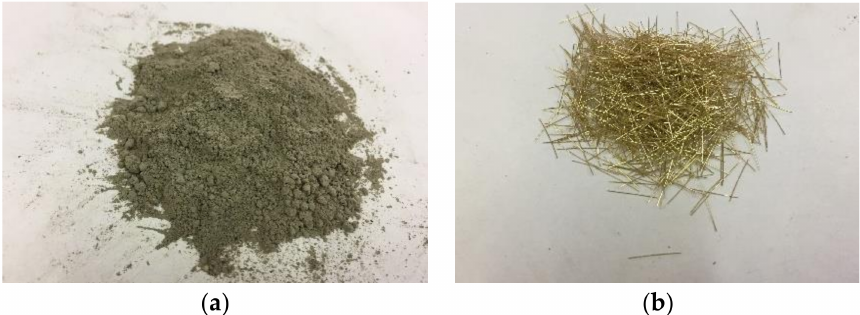
Figure 3. FRCC material components: ( a ) cement-based matrix; ( b ) steel fibers.